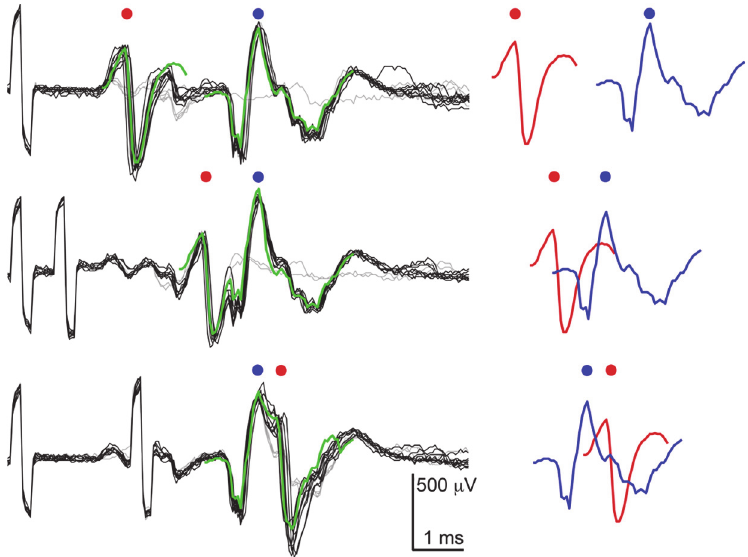
Fig 9. Addition of single spike waveforms from stimulation of two somas reproduces complicated wave shapes. Top trace shows the two stimulations far apart in time, so that the waveforms do not yet overlap. The middle and bottom traces show two different overlaps. The peaks of the individual waveforms are marked with dots corresponding to their color. Addition of the individual waveforms, shown in red and blue on the right, accurately reproduced the shape recorded in the channel as a result of two stimulations. The s- shaped pulses at the beginning of each trace are stimulation artefacts: the first one (the only one shown in the top trace) corresponds to the stimulus that evoked the blue spike, and the second one (not seen in top trace since it would be to the left of the signal shown) corresponds to the red spike. Some stimulations did not evoke spikes, and they are shown in